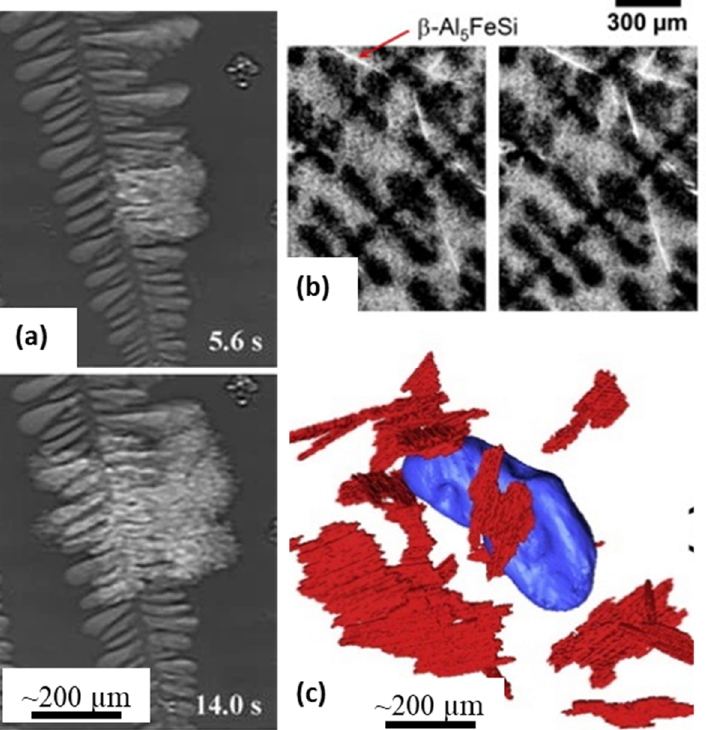
Figure 6. ( a ) Sr-modified irregular eutectic microstructure formation during directional solidification of an Al-Si-Cu-Sr alloy (after Mathiessen et al., [31]) ( b ) 2D slices of the tomographic data showing nucleation and growth of Fe-intermetallics (white) during dendritic (black) solidification of secondary aluminium. ( c ) 3D reconstruction of Fe intermetallics in ( b ) showing the origin and time of nucleation (after Puncreobutr et al. [33]). Permitted for reuse from respective publishers.